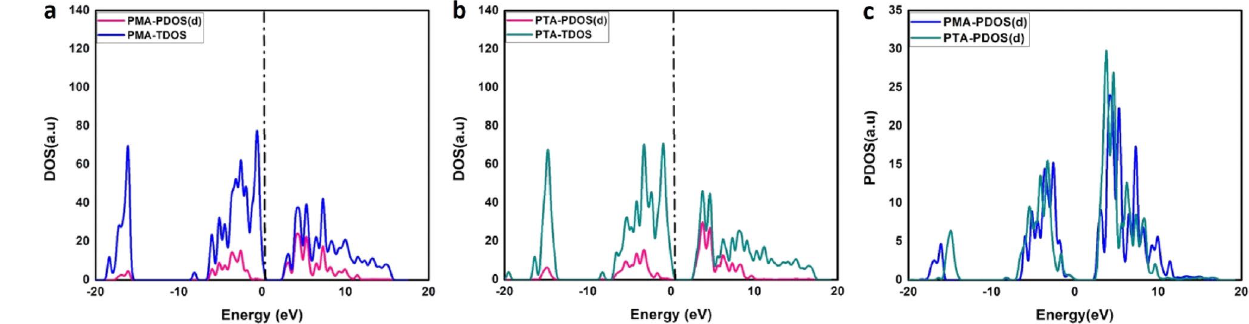
Figure 8. Total density of states (TDOS) and projected density of states (PDOS). ( a ) PMA, ( b ) PTA, and ( c ) PDOS of PTA and